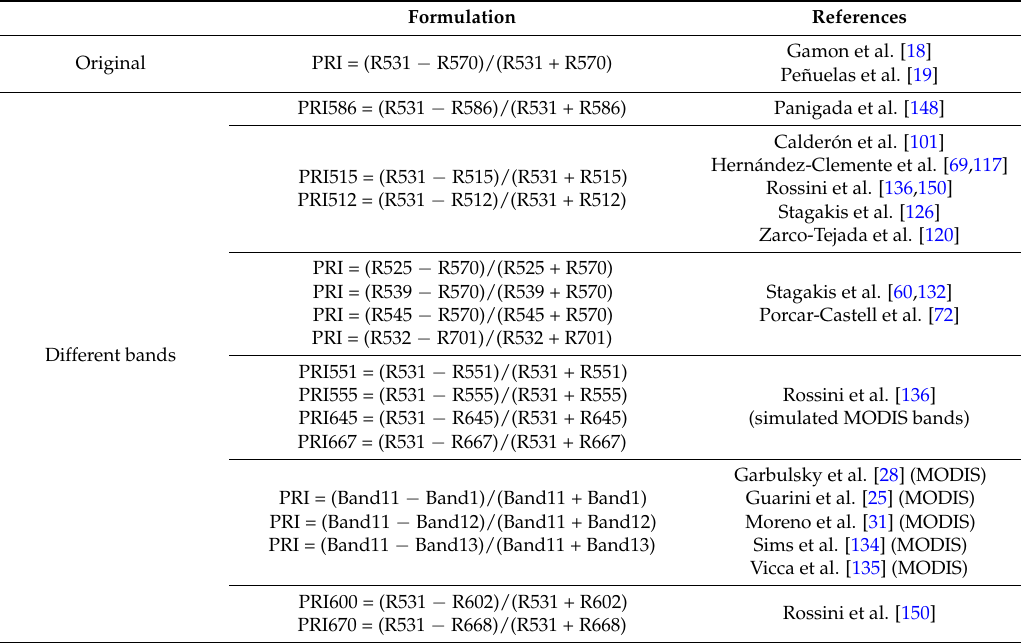
Table 2. PRI formulations for assessing RUE or net CO 2